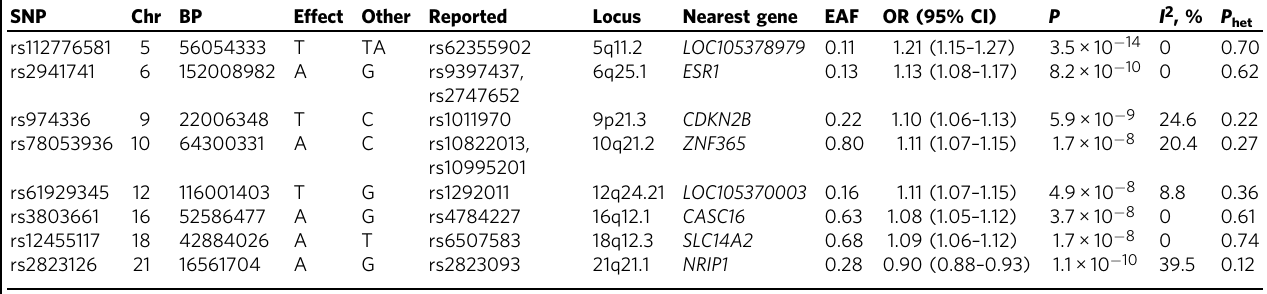
Table 3 Eight novel breast cancer risk-associated SNPs located within previously known loci in Asians: a conditional analysis. SNP Chr BP Effect Other Reported